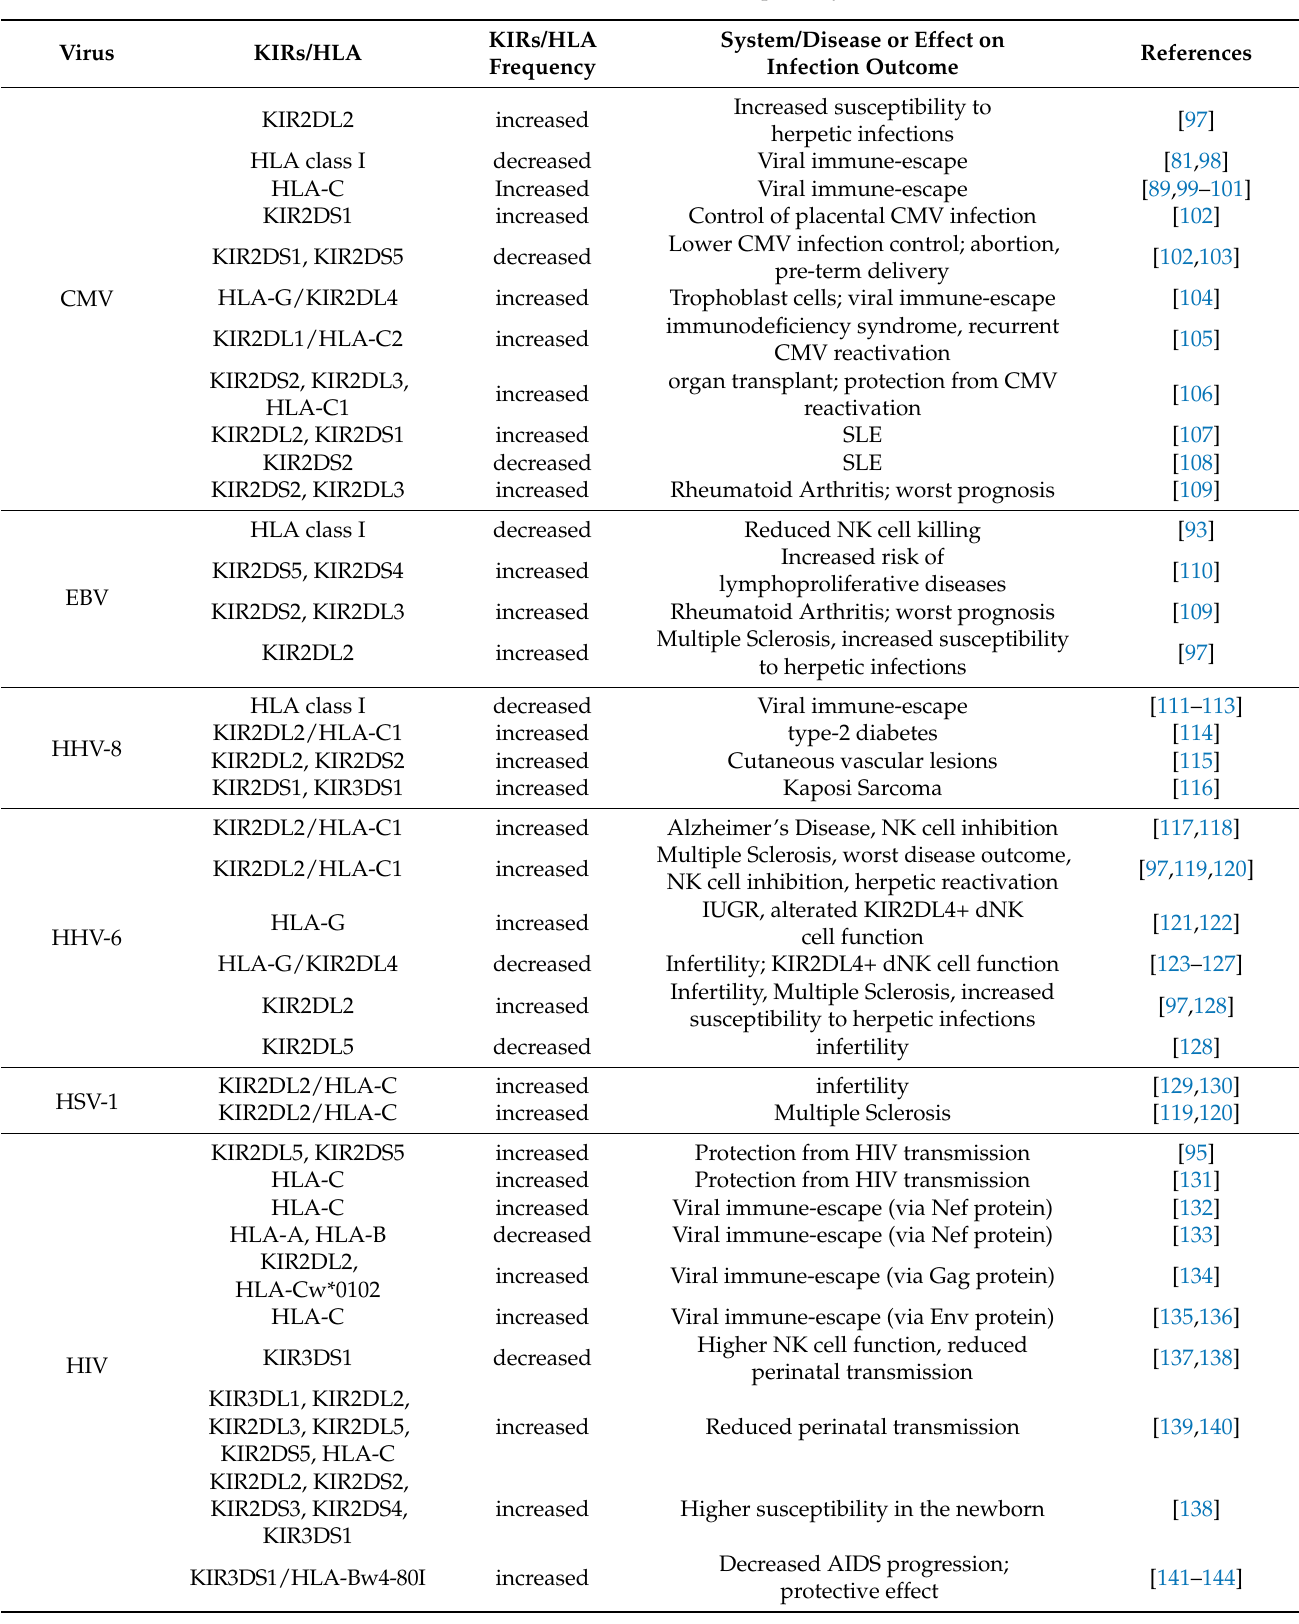
Table 2. Virus and KIRs/HLA association and possibly related